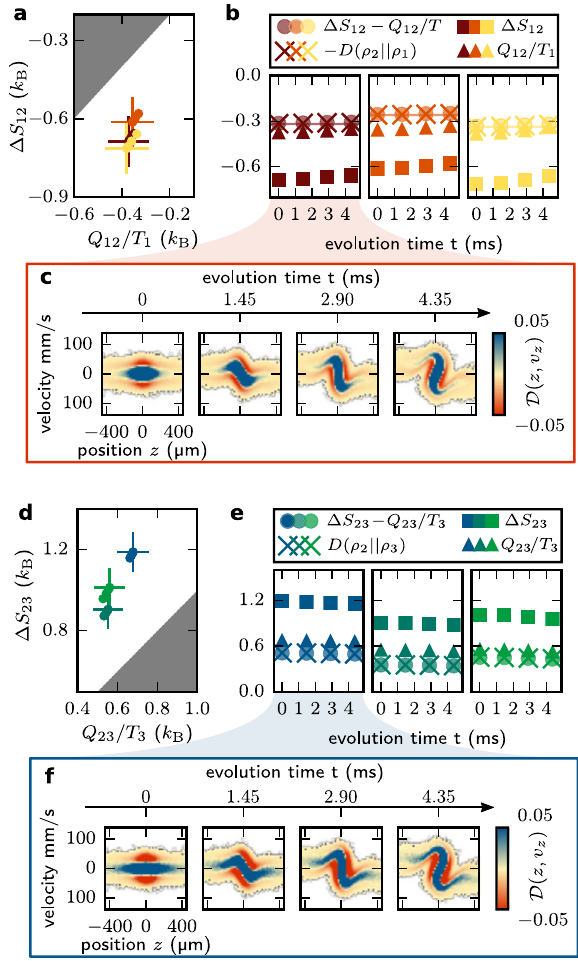
Fig. 2 Generalized Clausius inequalities. a Veri fi cation of the reversed generalized Clausius inequality (2) for the transition from ρ 1 to ρ 2 . The red, orange and yellow points correspond to molasses detunings of Δ f = − 82 MHz, − 62 MHz and − 42 MHz, respectively. b Time evolution cool of all thermodynamic quantities in the reversed Clausius equality; the solid gray line indicates the analytical result (3). The small drift is due to the normalization of the phase-space density which is truncated to the experimentally accessible position range. c Complex whorl dynamics entropy D for Δ f cool = − 82 MHz. d – f Analogous results to a – c for the generalized Clausius inequality (1). Error bars show statistical uncertainty of ± 1 σ standard